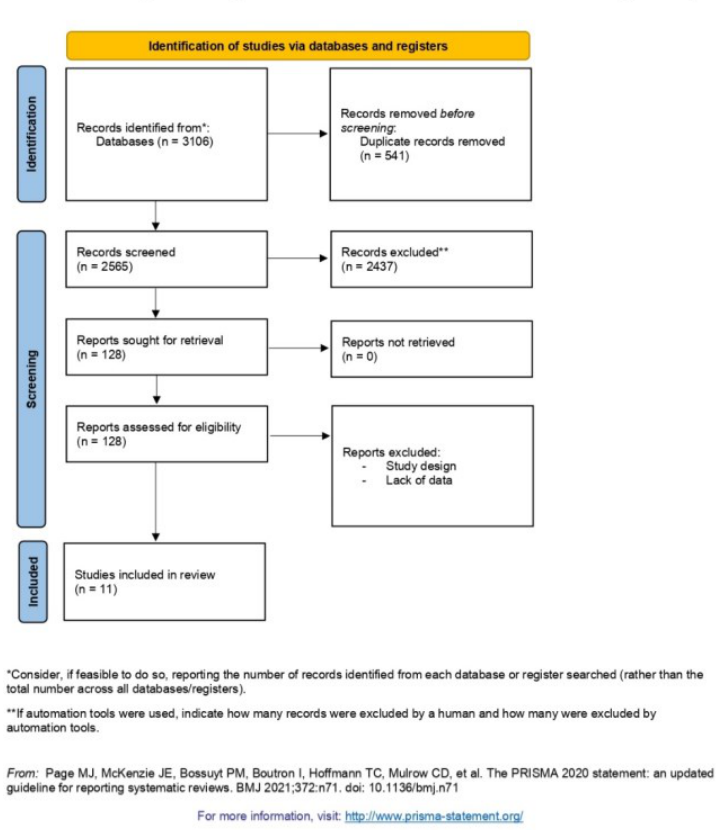
Figure 1. Flow chart of included studies.* Consider, if feasible to do so, reporting the number of